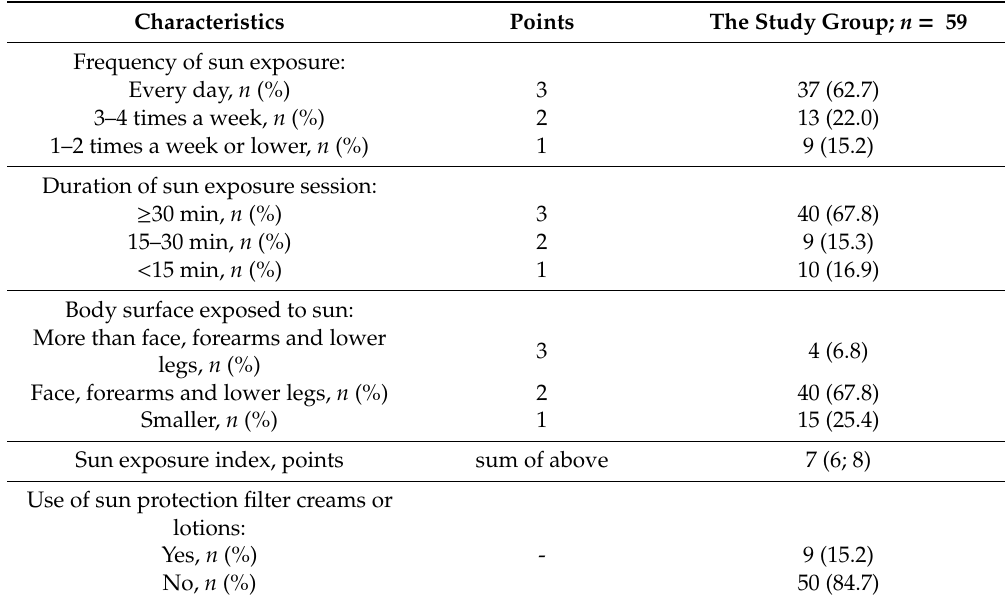
Table 2. Sun exposure in a period from April to October, as reported by the studied